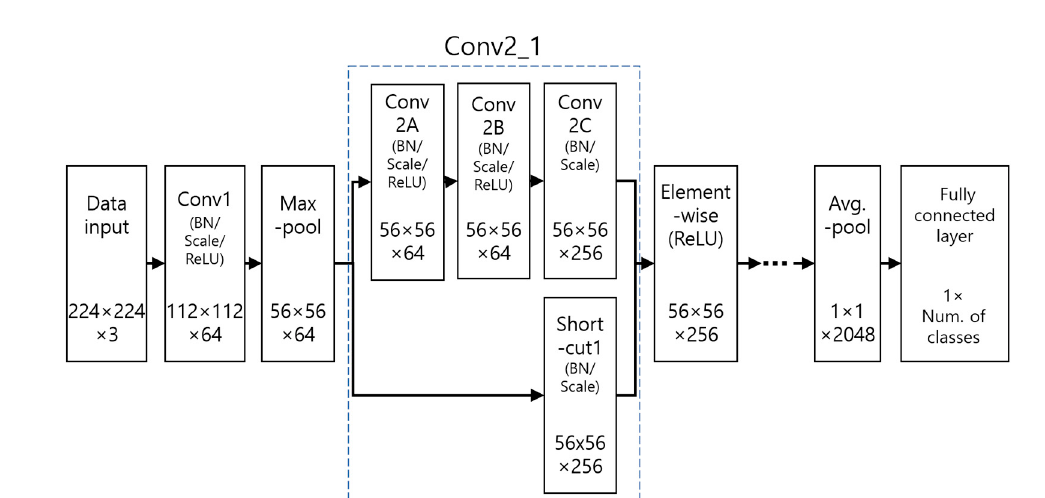
Figure 5. Detail description of residual block.